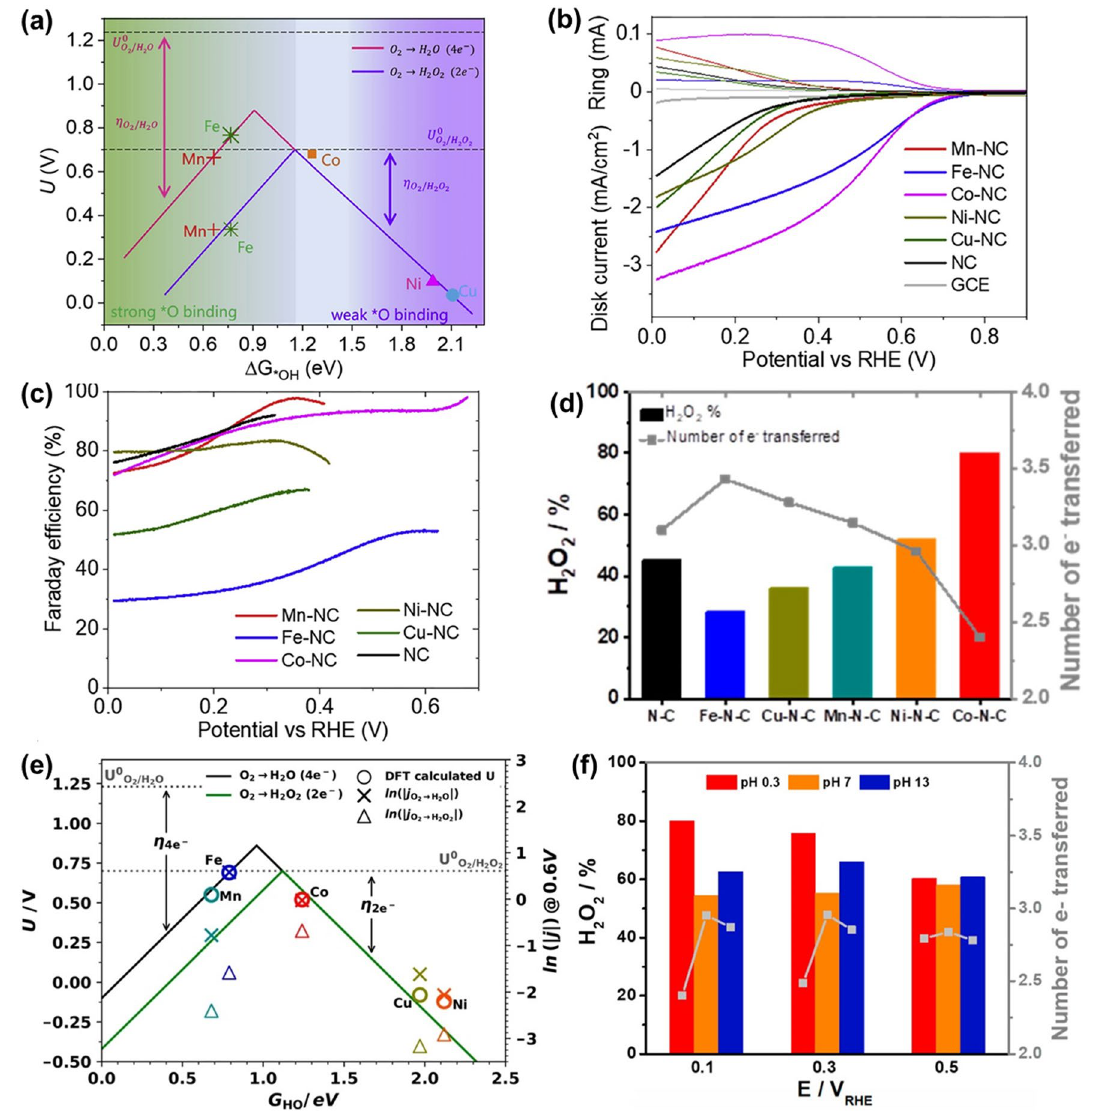
Fig. 17 a Activity-volcano plot of ORR through 2e − or 4e − route. b Linear sweep voltammograms (LSVs) of various catalysts in O 2 -saturated 0.1 M HClO 4 . c Faradic efficiencies of the H 2 O 2 formation at different potentials. Reproduced with permission from Ref. [246]. Copyright 2019 Elsevier. d H 2 O 2 selectivity and the number of electrons transferred ( n ) at +0.1 V RHE . e Activity-volcano plot for the ORR. f H 2 O 2 selectivity and the number of electrons transferred ( n ) at different potentials. Reproduced with permission from Ref. [247]. Copyright 2019 American